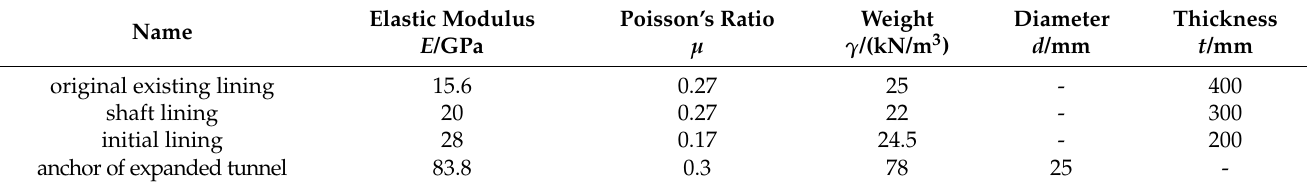
Table 2. Mechanical parameters of tunnel supporting